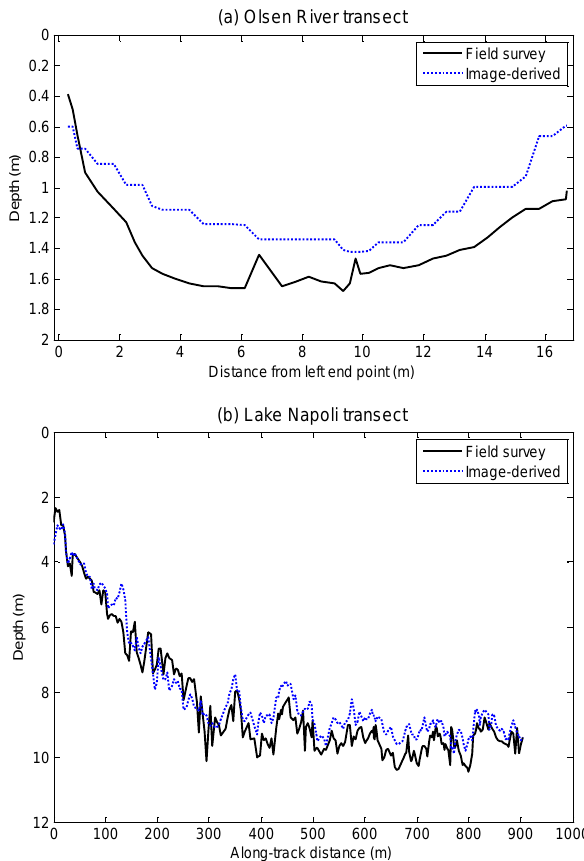
Fig. 8. Transects comparing field surveys and image-derived depth estimates obtained via quadratic OBRA for (a) a cross section of the Olsen River and (b) a boat track from the shore toward the center of Lake